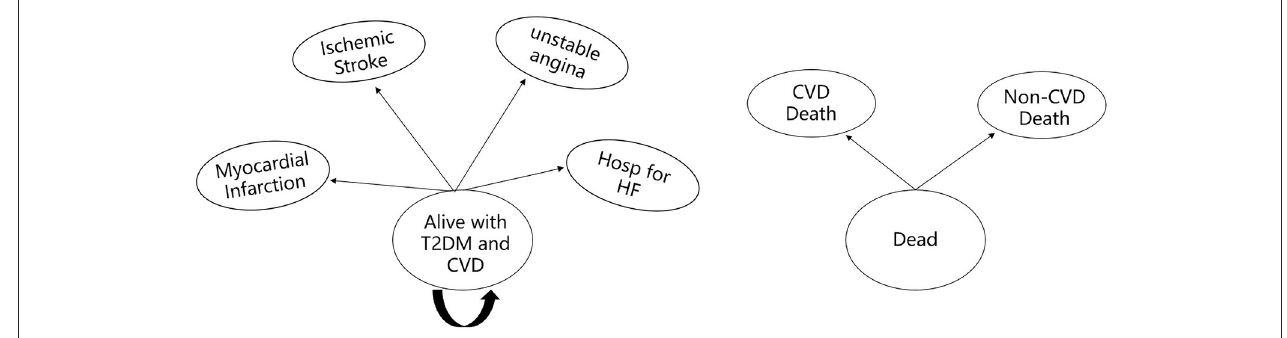
FIGURE 2 | Diagram of the “Alive with T2DM and CVD” and “Dead” health states. Hosp for HF, hospitalization for heart failure; CVD death, death from cardiovascular cause; Non-CVD death, death from non-cardiovascular